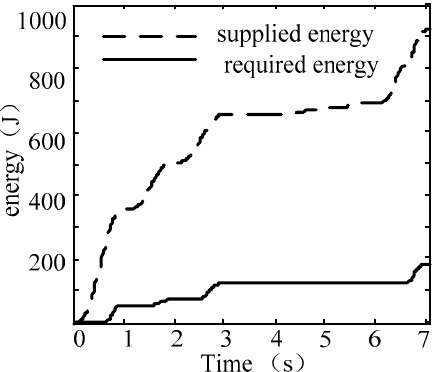
Figure 2. The energy curves of a hydraulic joint on the mobile manipulator.